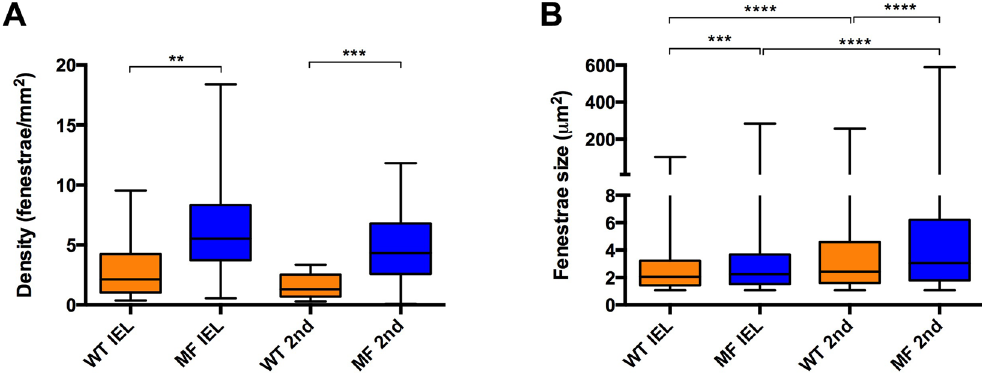
Figure 4. Quantitative analysis of density and size of fenestrae seen in IEL and 2 nd elastic laminae from en- face maximal projection images. Fenestrae density ( A ) and size ( B ) seen in WT (orange) and Marfan (MF, blue) IEL and 2 nd lamellae. Statistical significance between groups is indicated by asterisks, and defined in the Materials and Methods section. Interquartile boxplots with minimum and maximum whiskers. Forty maximal projections were analysed and a total of 6,400 fenestrae were